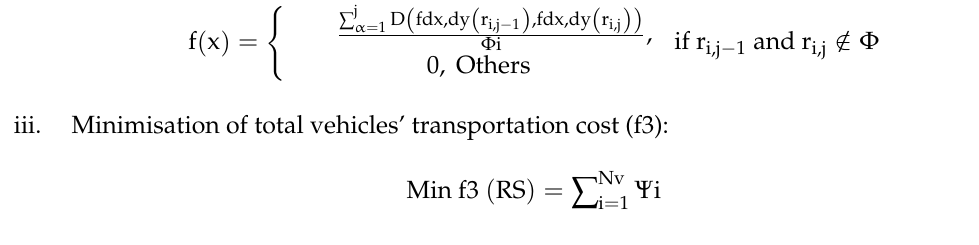
Table 1. Variables and description used in the